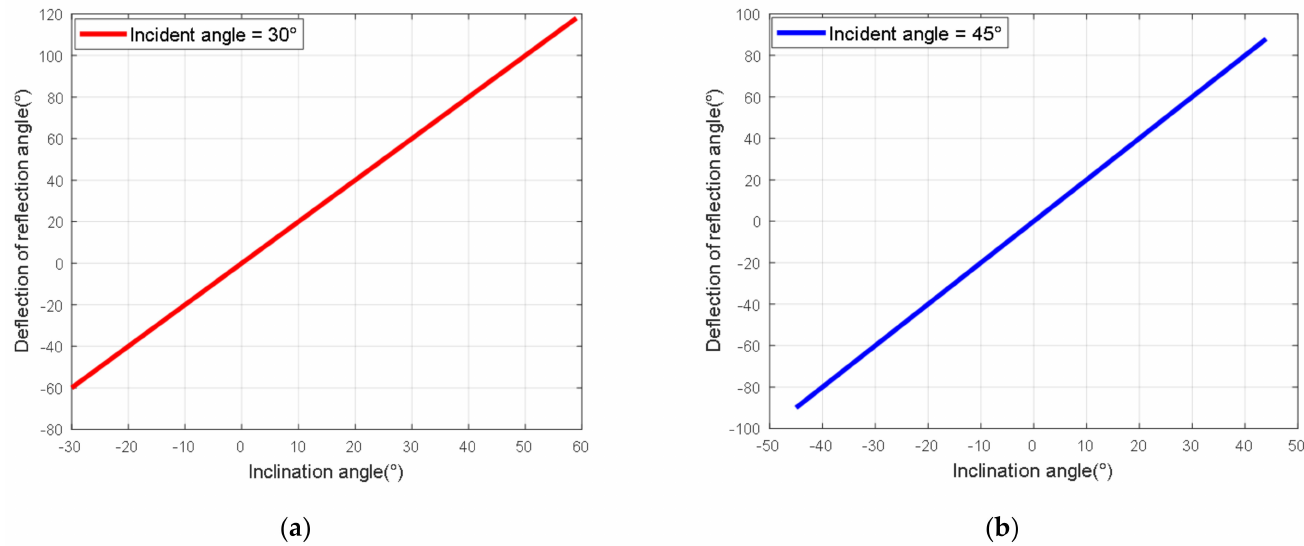
Figure 8. ( a ) Deflection of the reflection angle ψ as a function of the inclination of the WAI when θ pro = 30 ◦ . ( b ) Deflection of the reflection angle ψ as a function of the inclination of the WAI when θ pro = 45 ◦